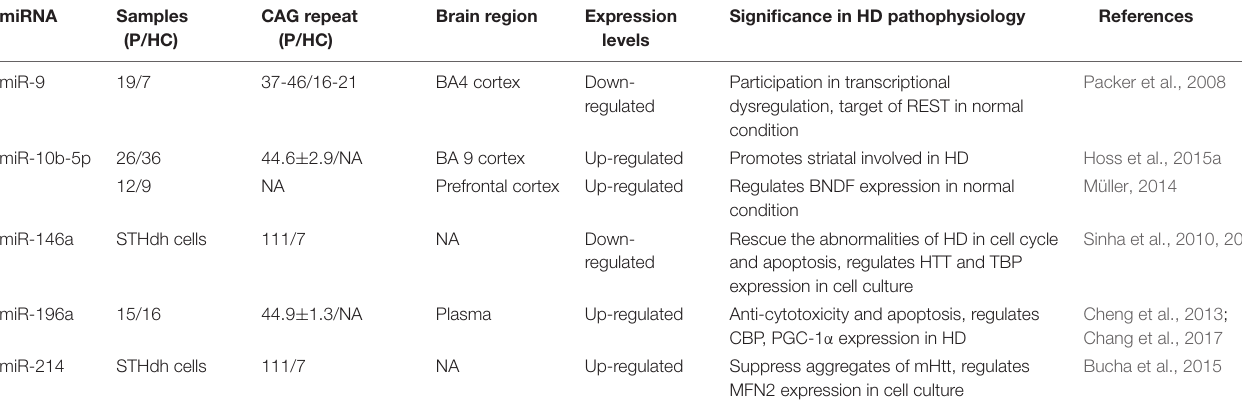
TABLE 1 | Some of the miRNAs most commonly associated with